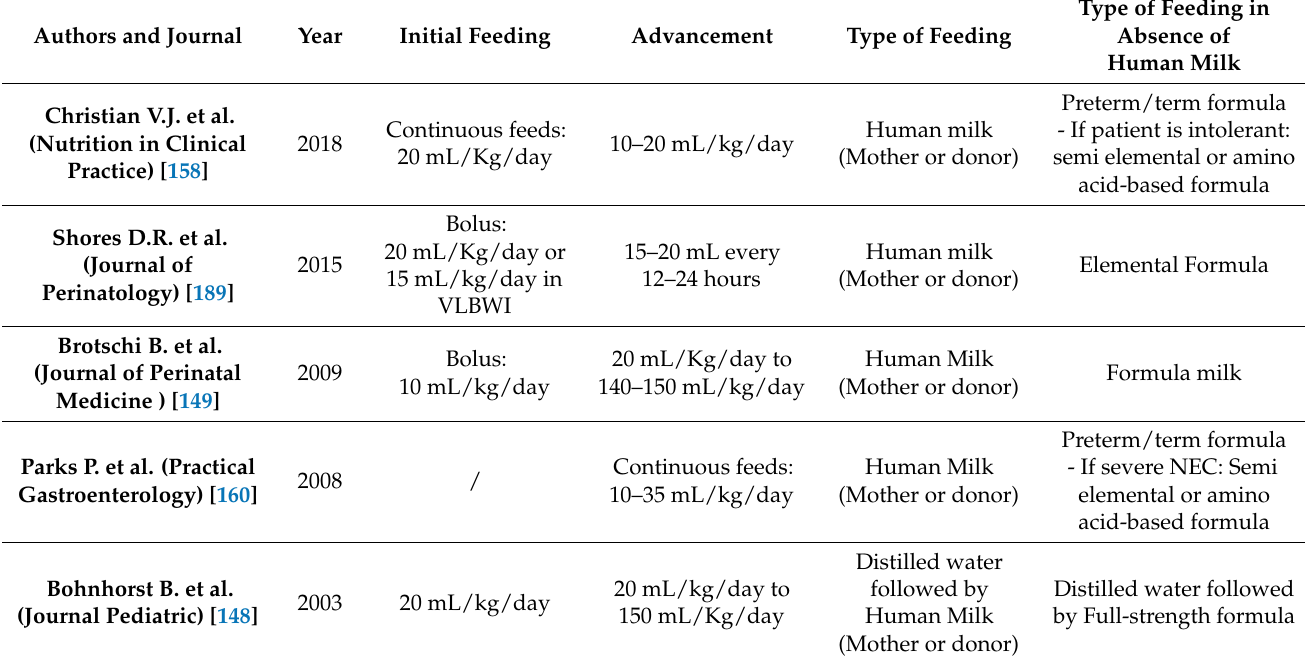
Table 1. Summarizes the Proposed Refeeding protocols after NEC in the current